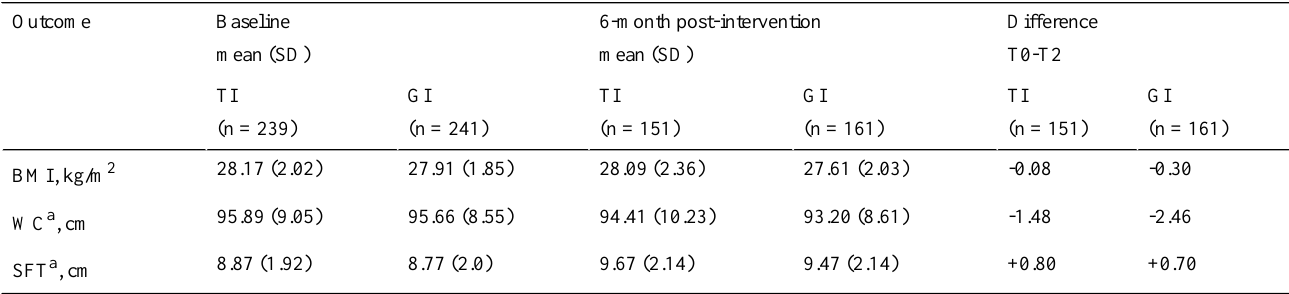
Difference T0-T26-month